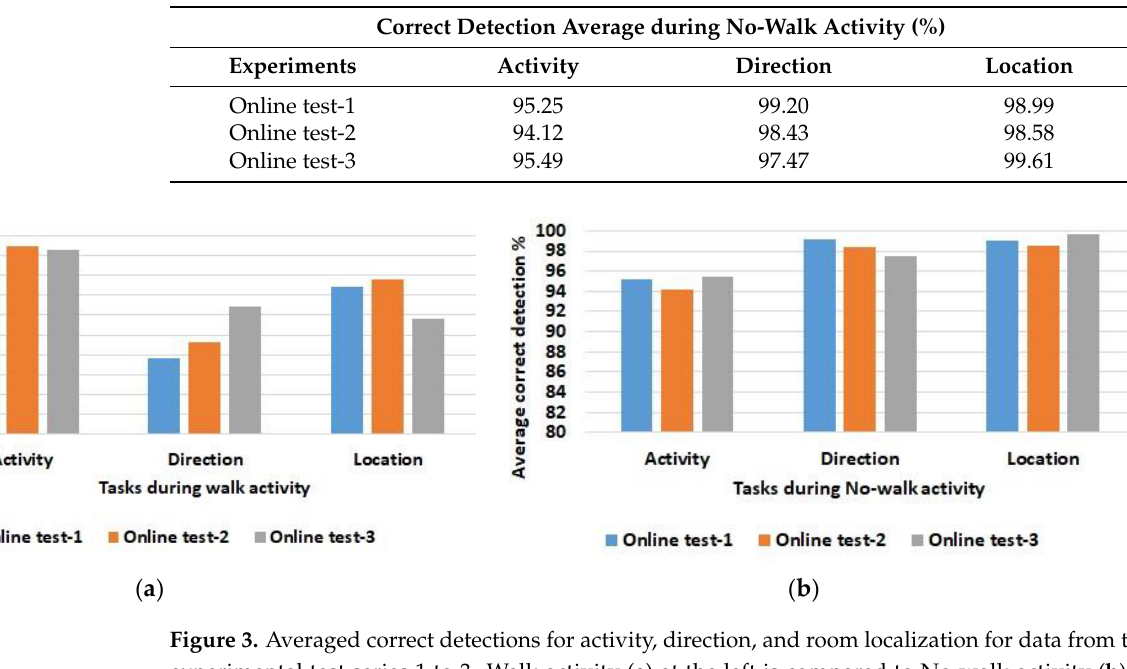
Table 8. Average of correct detections for each task during no-walk activity based on data from all three online test series.